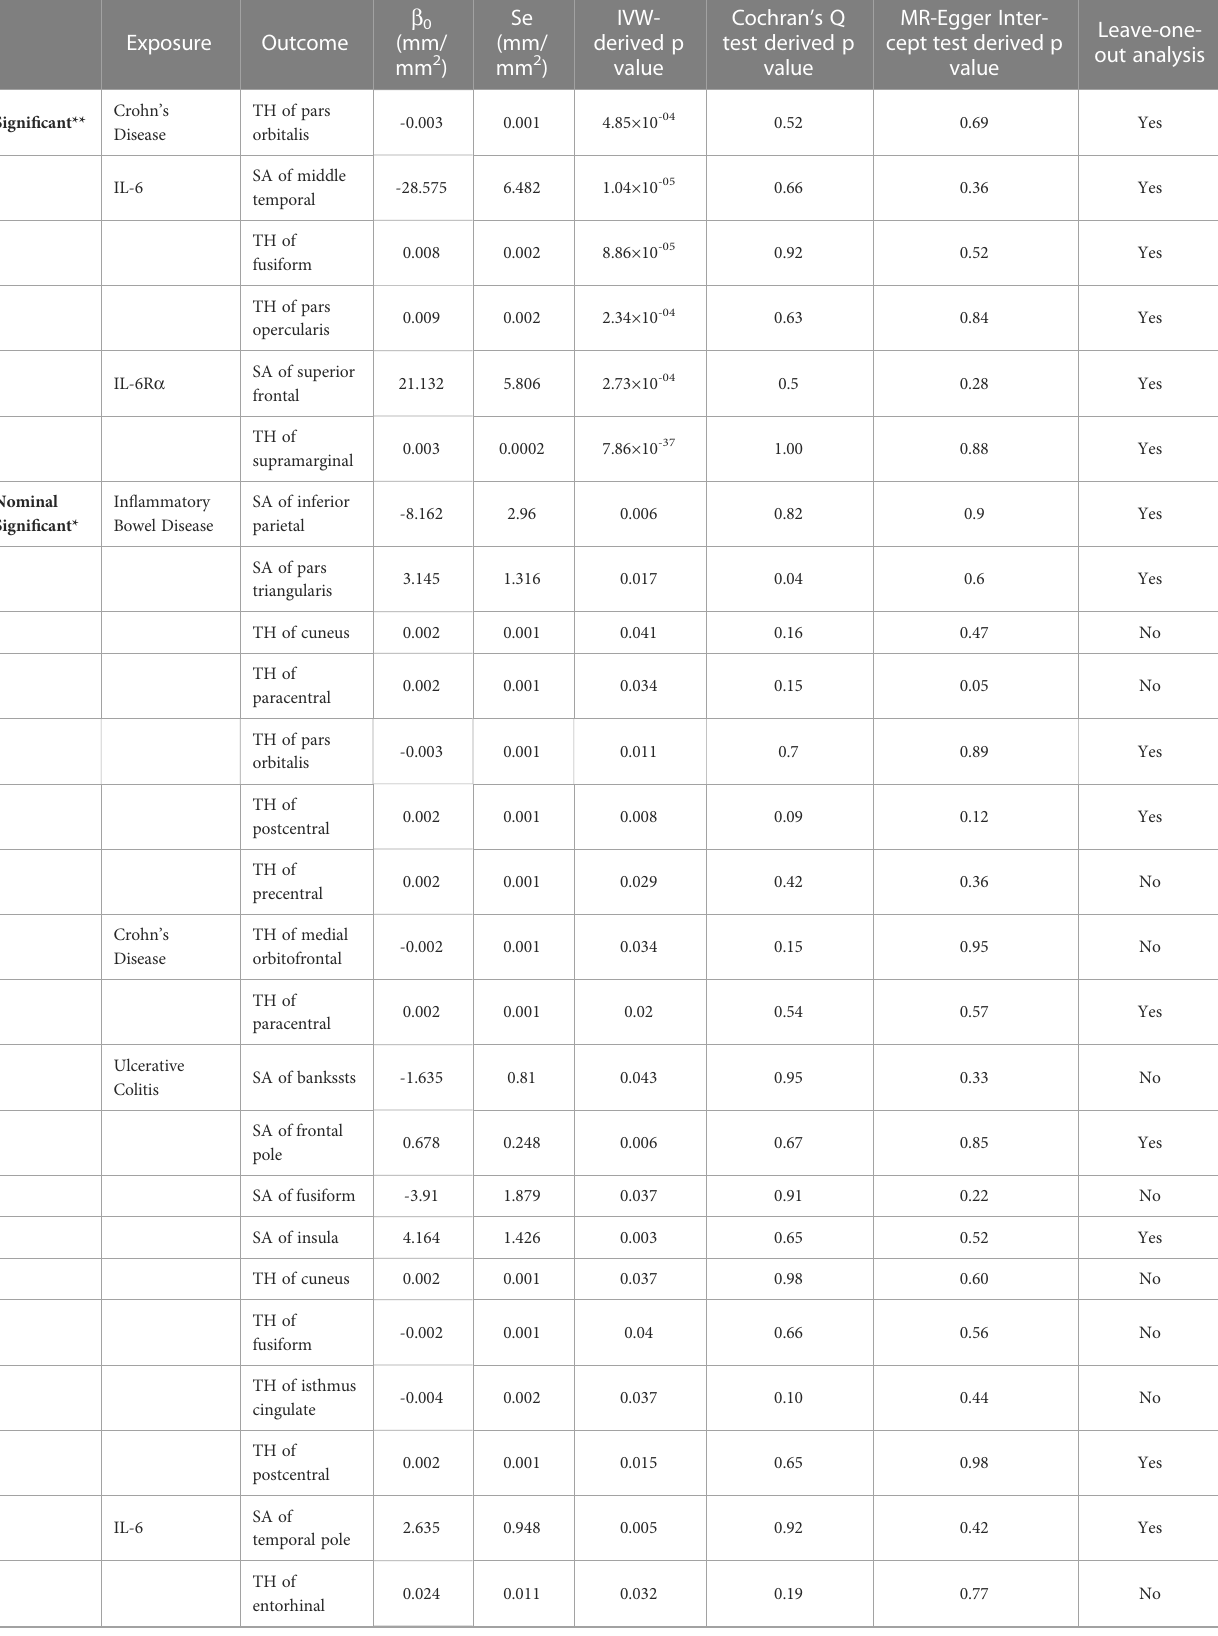
TABLE 1 Signi fi cant and nominal signi fi cant results from Mendelian Randomization analysis.